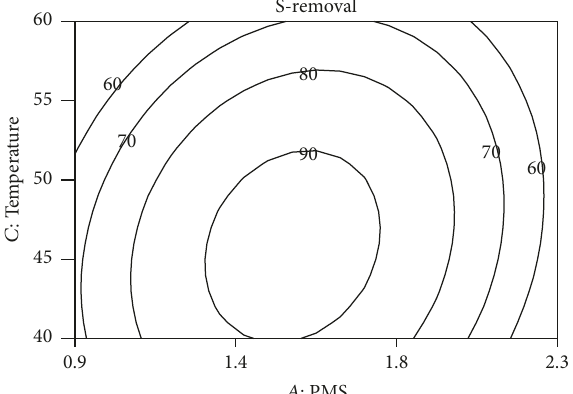
Figure 6: The contour plot about effect of [BMIM]Cl/CoCl 2 dosage and time interaction on